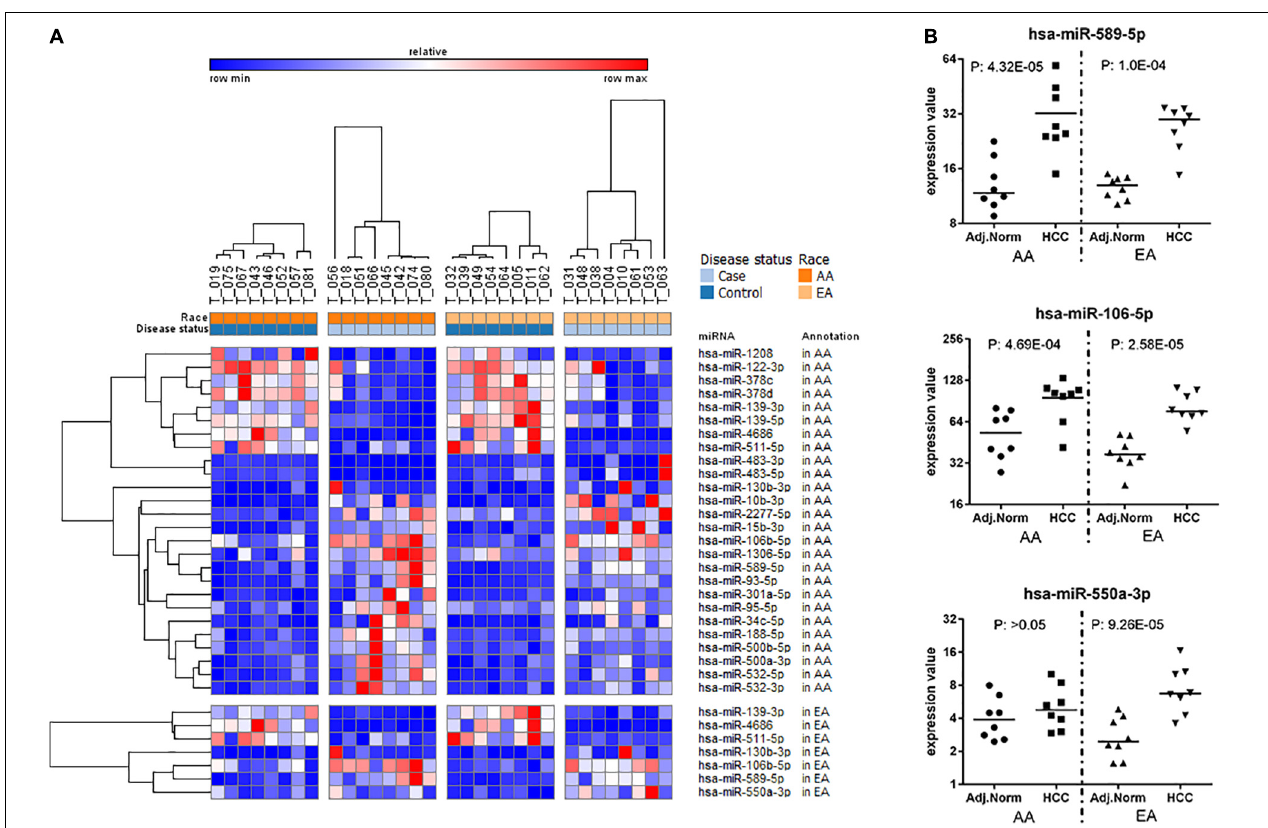
FIGURE 3 | Differentially expressed miRNAs in tumor vs. non-tumor tissues in EA and AA. (A) Differentially expressed miRNAs comparing HCC vs. non-tumor tissues in AA (Piletic and Kunej, 2016) and EA (Mehrotra et al., 2004). (B) Dot plots for three selected miRNAs differentially expressed in tumor vs. non-tumor tissues in AA and